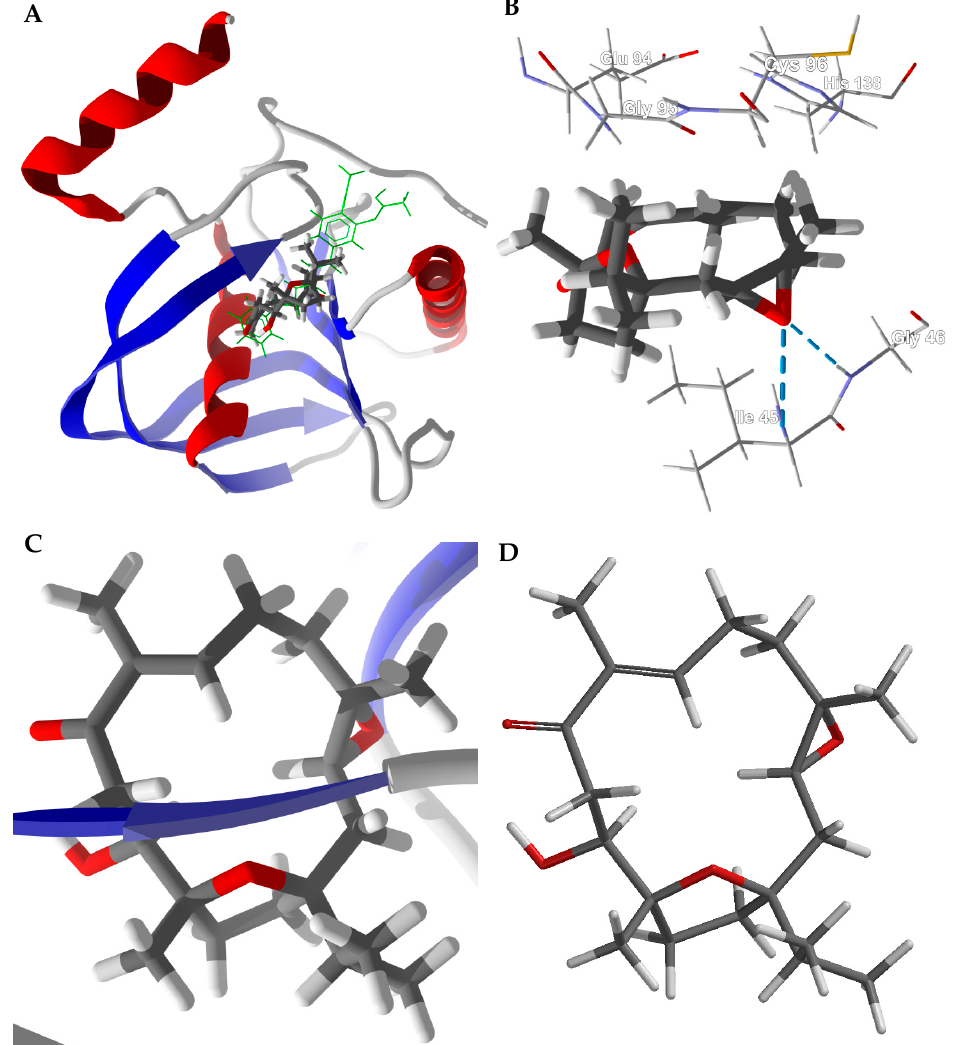
Figure 6. Docking of boscartin G with Helicobacter pylori peptide deformylase (HpPDF, PDB 2cek). ( A ): Ribbon structure of HpPDF showing boscartin G in the active site; the co-crystallized ligand, 4- stick figure. ( B ): Key interactions of boscartin G in the active site of HpPDF; hydrogen-bonds are shown as blue dashed lines. ( C ): Conformation of boscartin G docked to HpPDF. ( D ): Lowest-energy conformation of boscartin G determined by density functional calculations (M06-2X/6-31G*/SM8)